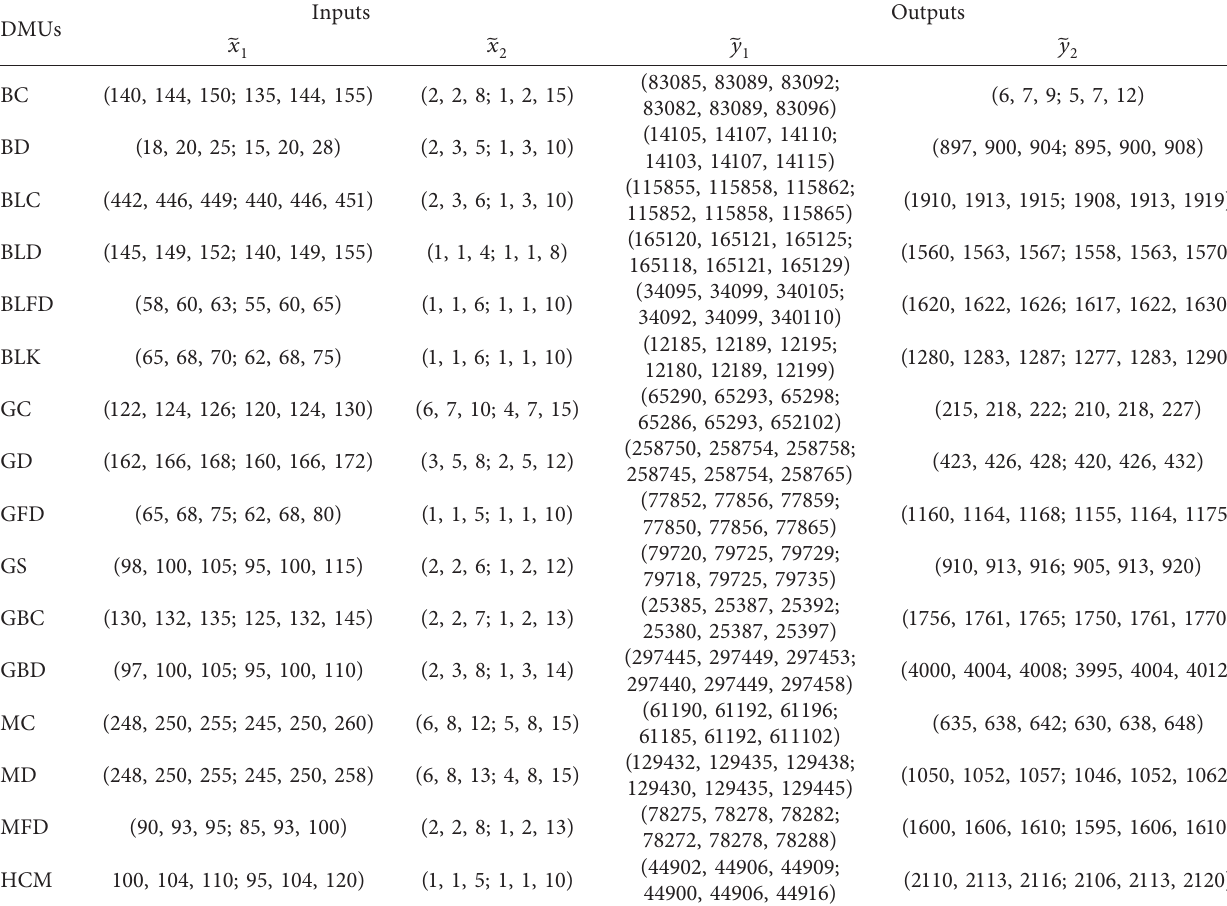
Table 5: IFNs as inputs and outputs of 16 public hospitals of Meerut in the Indian state of Uttar Pradesh (Arya and Yadav [45]).